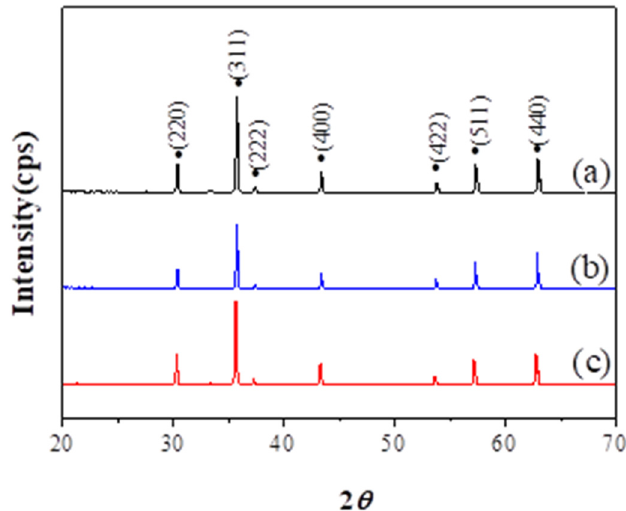
Figure 8. The X-ray diffraction patterns of the Ni 1 − x Zn x Fe 2 O 4 (x = 0.5, 0.6, 0.7) samples sintered at 1250 °C: ( a ) x = 0.5, ( b ) x = 0.6, and ( c ) x = 0.7.